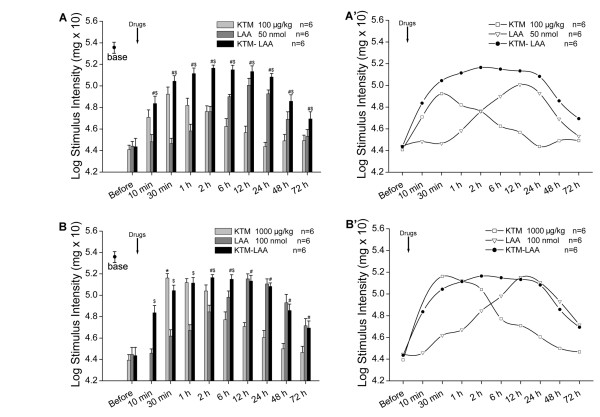
Effects of combining ketamine with LAA on SNL-induced mechanical allodynia. PWTs of coadministration group were much higher than that of individual ketamine (100 μg/kg) or LAA (50 nmol) injection at any time points after administration (A). #, $ P < 0.05 compared with that of ketamine 100 μg/kg or LAA 50 nmol, respectively. A', Schematic curves according to A implied that compared with that of individual administration, the anti-allodynia effect of coadministration was more quick, stable and persistent. The analgesic effects of coadministration (100 μg/kg of ketamine and 50 nmol of LAA) compared with that of higher doses of individual ketamine (1000 μg/kg) or LAA (100 nmol), respectively (B). * P < 0.05 compared with that of Ketamine-LAA group. #, $ P < 0.05 compared with that of 1000 μg/kg of ketamine or 100 nmol of LAA, respectively. B', Schematic curves according to B implied that even compared with that of higher doses of individual administration, the anti-allodynia effect of coadministration was still more stable and long-lasting.